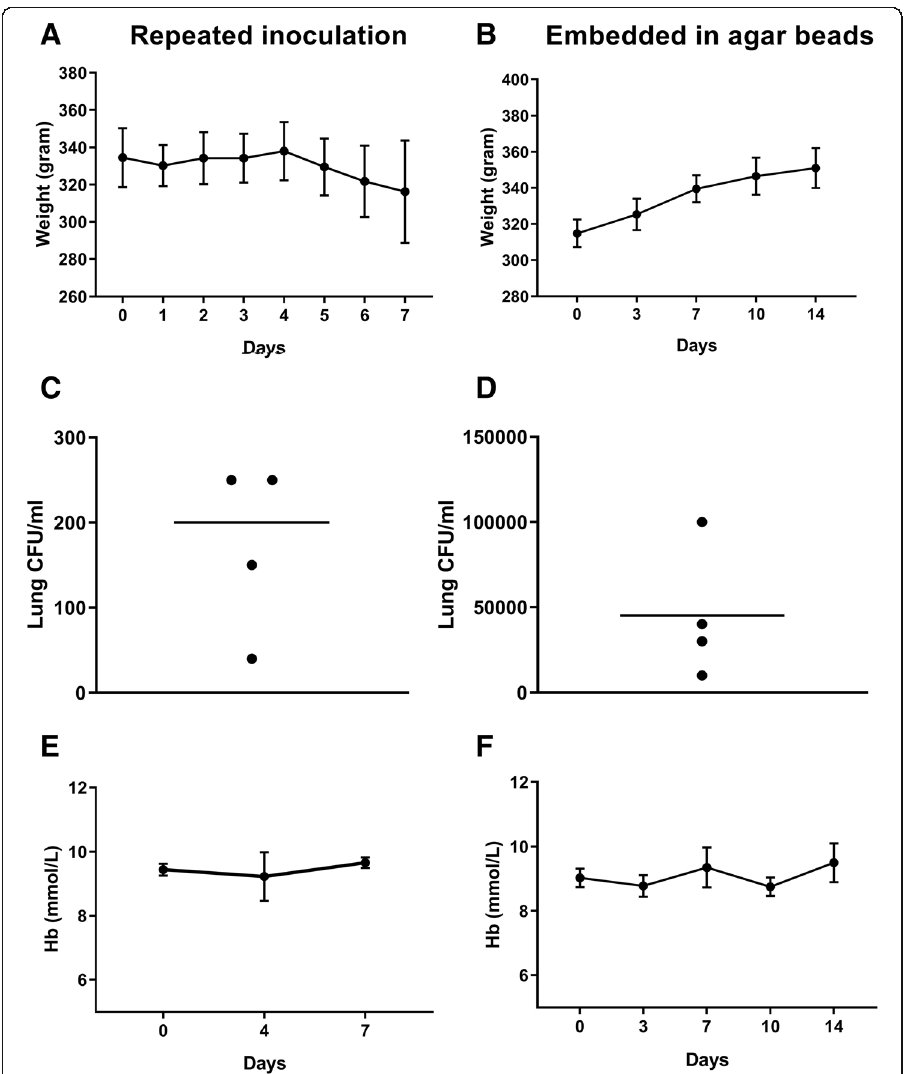
Fig. 2 Failed attempts to establish rat AI model using S. pneumoniae . Daily weight ( a ), lung CFU/ml after 7 days ( b ), and Hb levels ( c ) of rats inoculated with a log-phase culture of 10 7 CFU S. pneumoniae at day 0 and day 4. The daily weight ( d ), lung CFU/ml ( e ), and Hb levels ( f ) of rats inoculated with a log-phase culture of 10 6 CFU S. pneumoniae embedded in agar beads. N = 4 and data are expressed as mean + SD ( n = 4). *** P < 0.001, ** P < 0.01, * P <